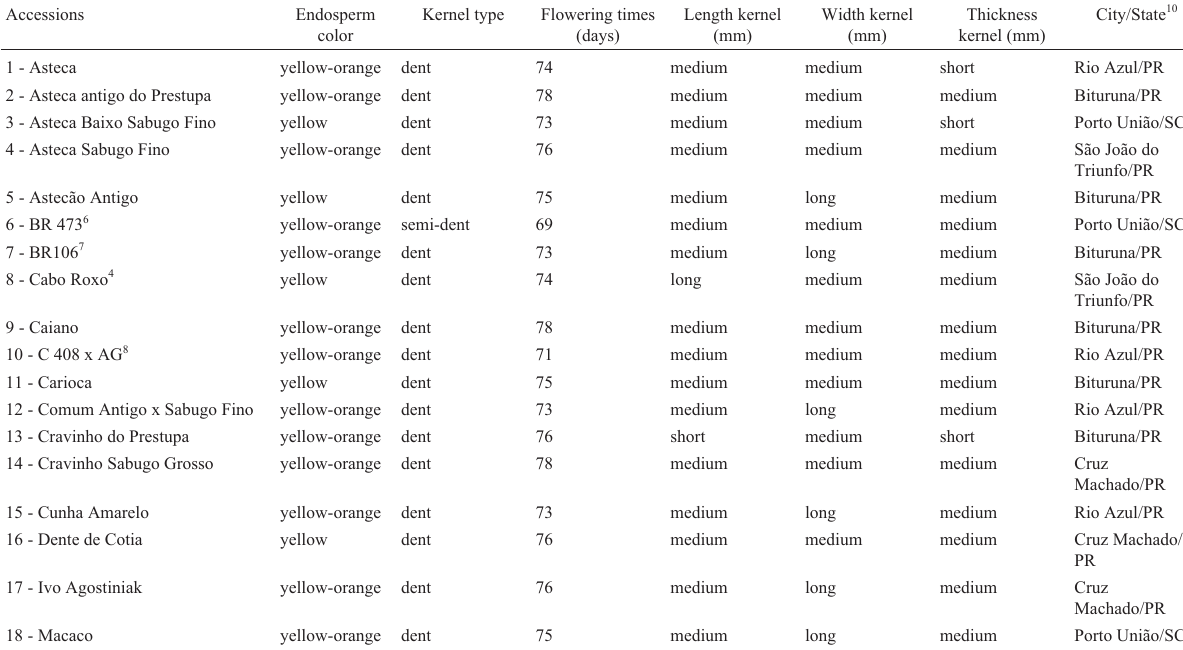
Table 1 - Accessions of maize studied, morphological characteristics and